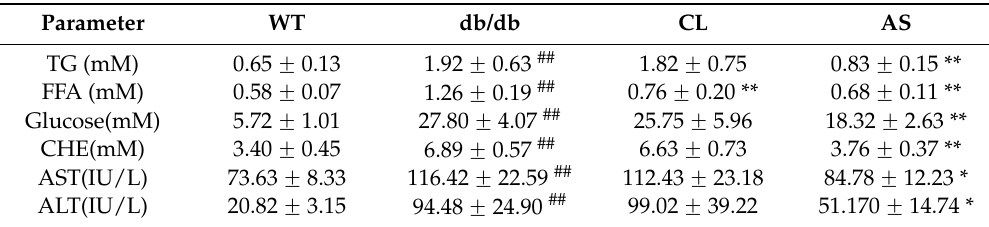
Table 1. AS reduced the blood lipids and hepatic enzyme levels in db/db mice.